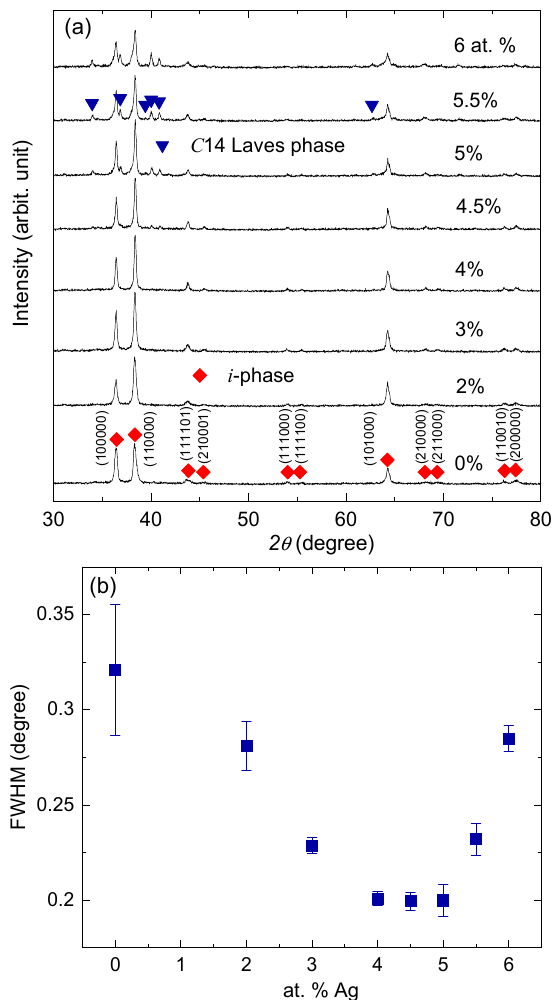
Figure 1. ( a ) XRD patterns of as-cast (Ti 35.2 Zr 43.8 Ni 21 ) 100 − x Ag x alloys. The i -phase and C 14 Laves phase were marked by red diamonds ( ◆ ) and blue triangles ( ▼ ), respectively. ( b ) FWHM of the i -phase as a function of Ag concentration, which was calculated from the (100000) reflection. Errors indicate the standard deviation.